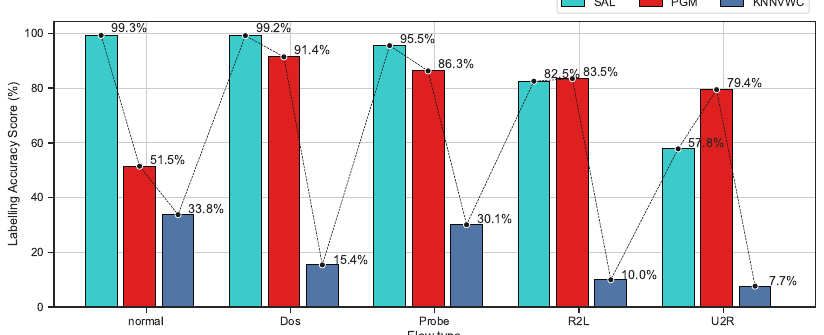
Figure 8. Comparison of labeling processes based on recall metrics on the NSL-KDD dataset.